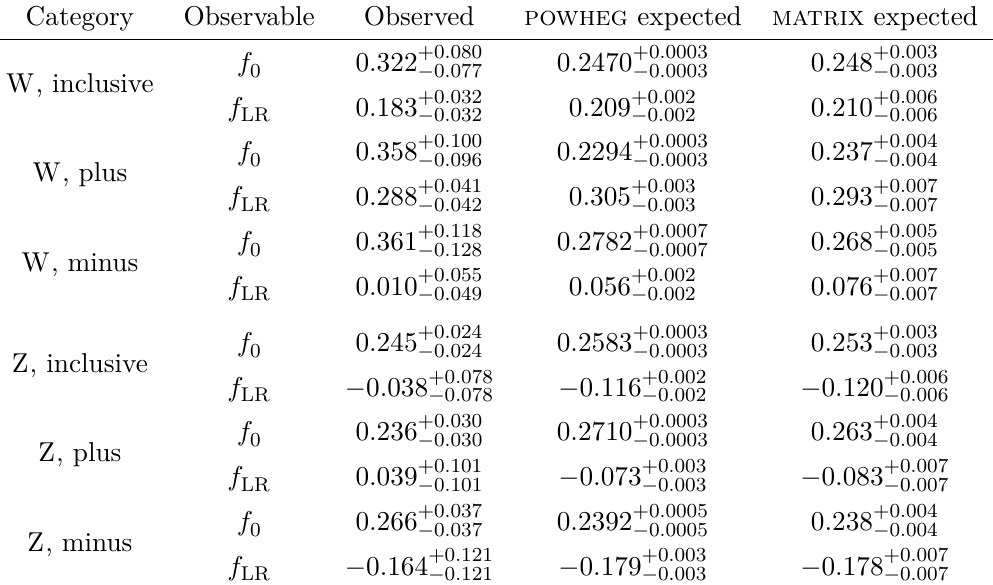
Table 11 . Standard model predictions and measured values of the W and Z polarization parameters for inclusive WZ production and each of the charged final states. The label Category indicates the targeted boson and total leptonic charge. The SM values are estimated from the nominal powheg sample and the matrix shapes by performing a quadratic fit to the generator level cosine of the polarization angle with no fiducial cuts applied and computing the polarization fractions from the fitting parameters. Uncertainties in the powheg measurements correspond to the PDF uncertainties, while those included for matrix relate to the overall numerical